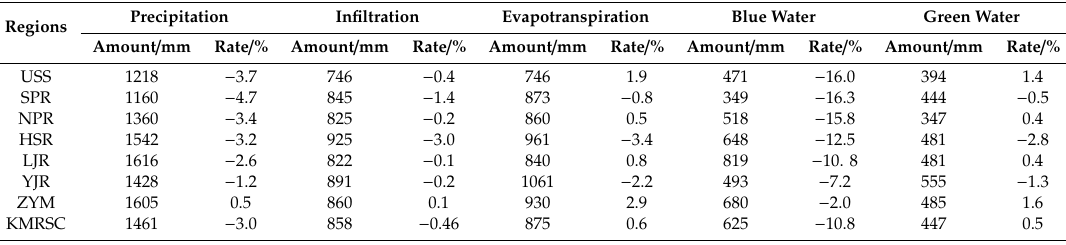
Table 9. Annual average of water cycle fluxes during the prediction period and their change rates compared to the base period results.